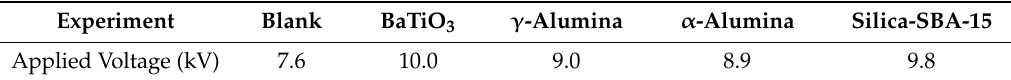
Table 2. Voltage applied for the nonpacked reactor (Blank) and the packed reactor with di ff erent dielectric materials.